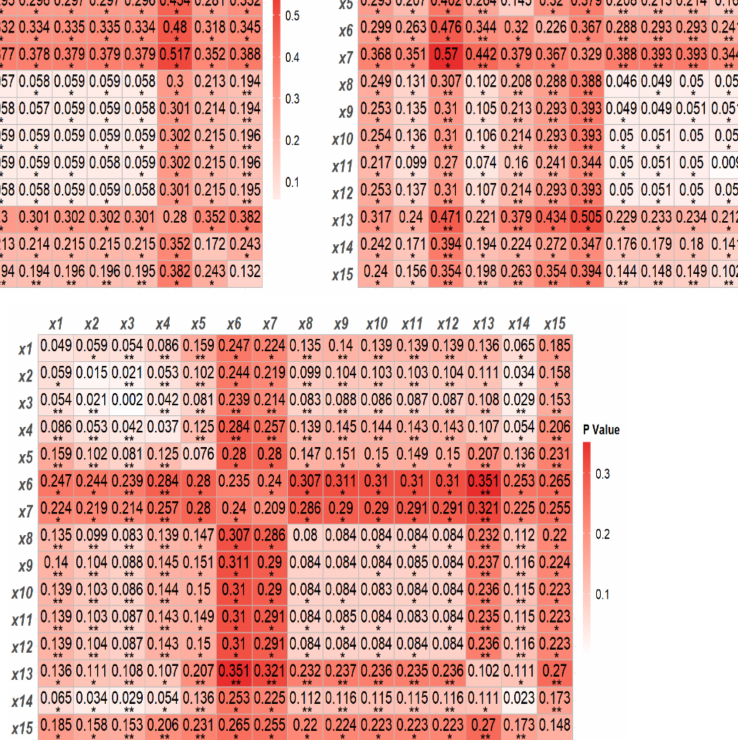
Figure 7. The explanatory power of interaction between factors in 2001, 2008, 2019. (* represents a two-factor enhanced interaction, ** represents a non-linear enhanced interaction, p value represents the interaction detection value of the two